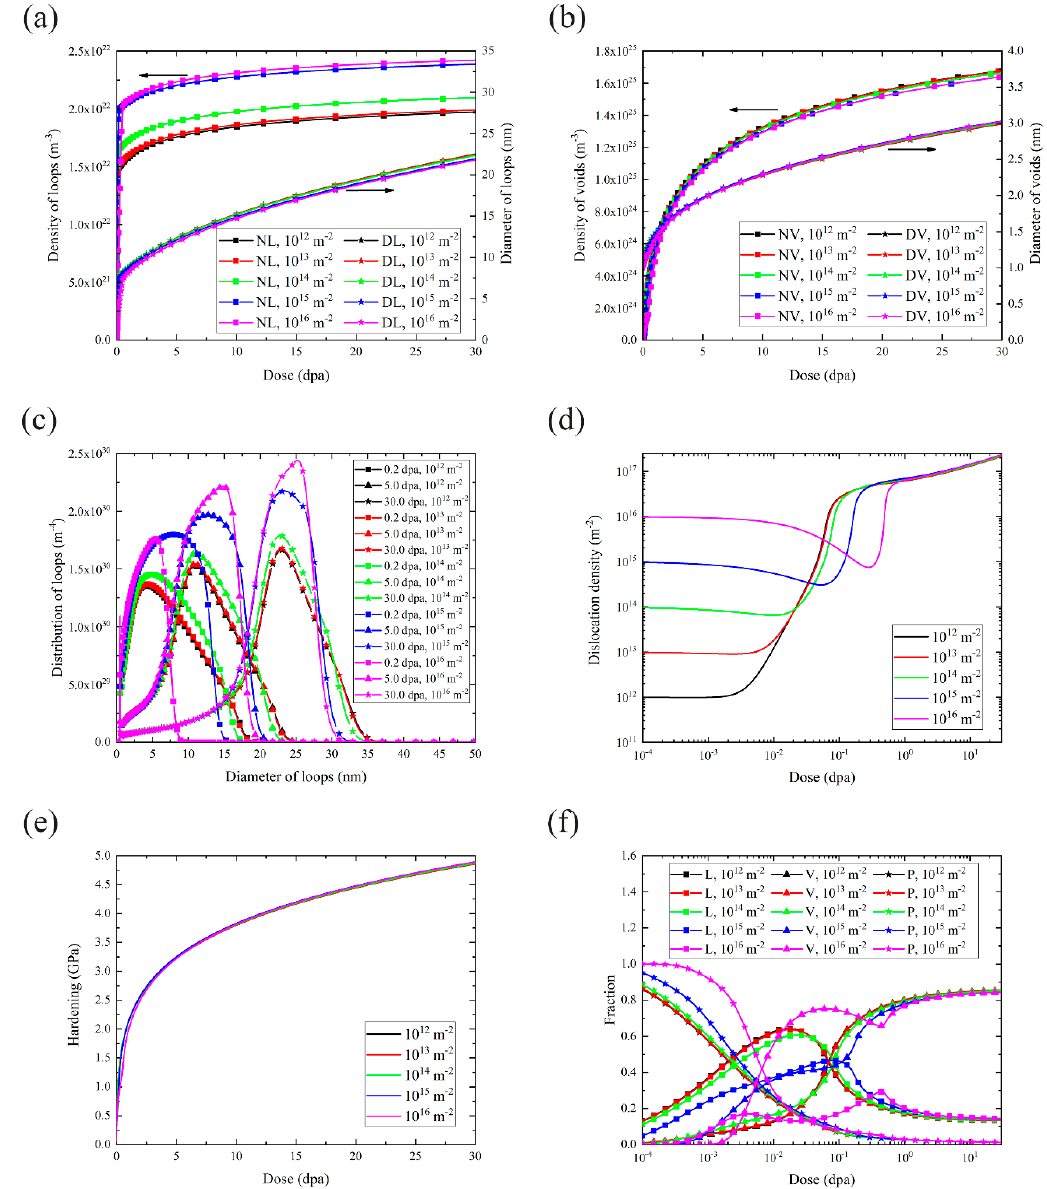
Figure 3. Rate theory calculations with various initial dislocation densities. ( a ) Number density and diameter of loops. ( b ) Number density and diameter of voids. ( c ) Distribution of loops at 0.2 dpa, 5 dpa and 30 dpa. ( d ) Dislocation density. ( e ) Hardening. ( f ) Contribution of loops (L), voids (V) and precipitates (P) to hardening.